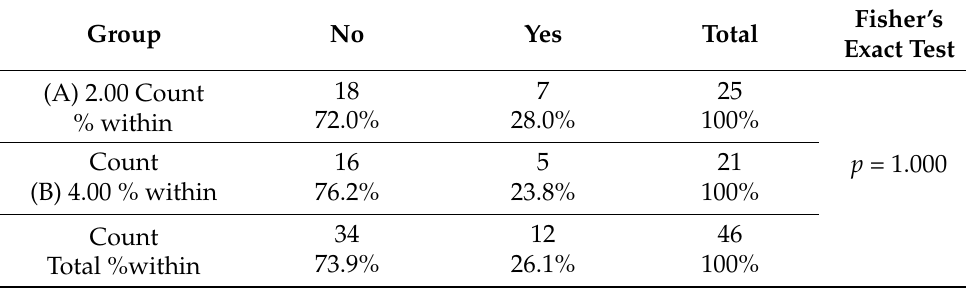
Table 3. Chi-square tests (No/Yes) attachment